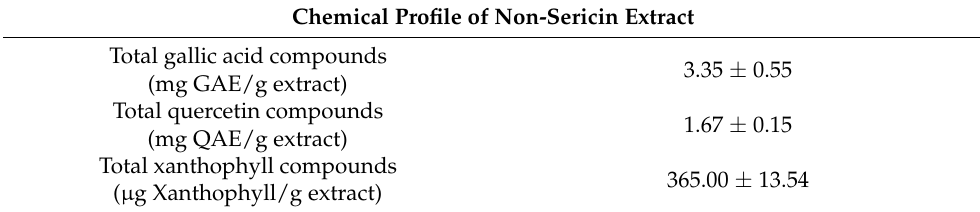
Table 2. The chemical profile of non-sericin extract accessed by HPLC. The gallic acid, quercetin and xanthophyll content were